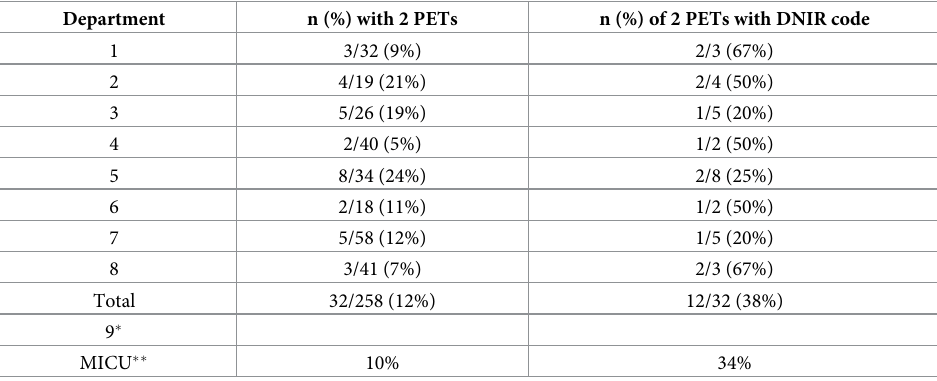
Table 1. Incidence of patients with two or more perceptions of excessive treatment and do-not-intubate and resuscitate order in the 10 participating departments over one week pilot study (conducted in July